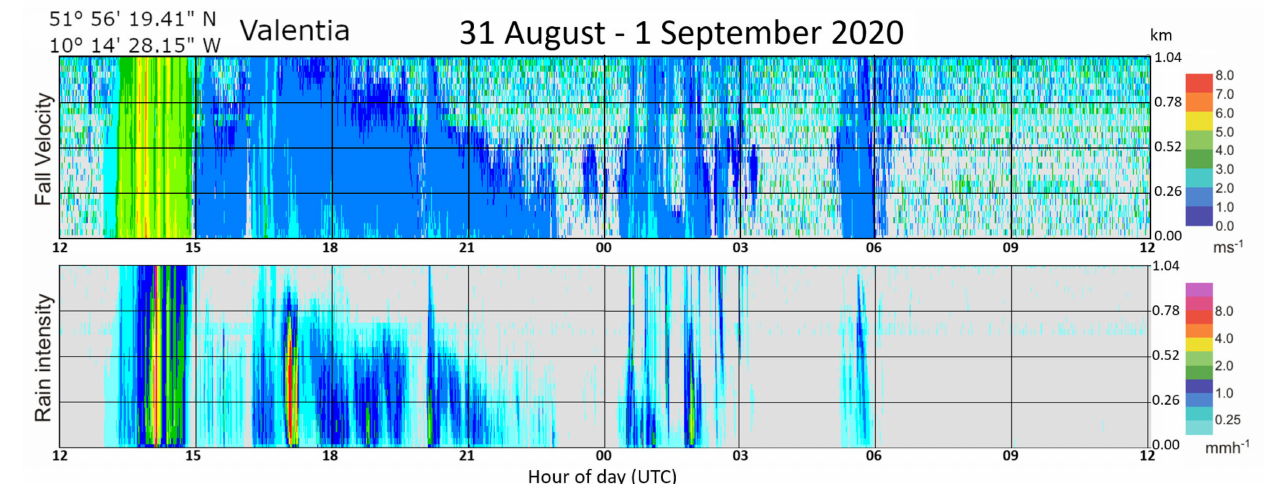
Figure 1. Retrieval of the fall velocity and rain intensity during a precipitation event over the Valentia (SW Ireland) MRR site for 31 August through 1 September 2020. Note the vertical scale, from 0 to 1.04 km, showing that much of the precipitation was below 1 km, with a dominance of light rain intensities of 1 mm/h or